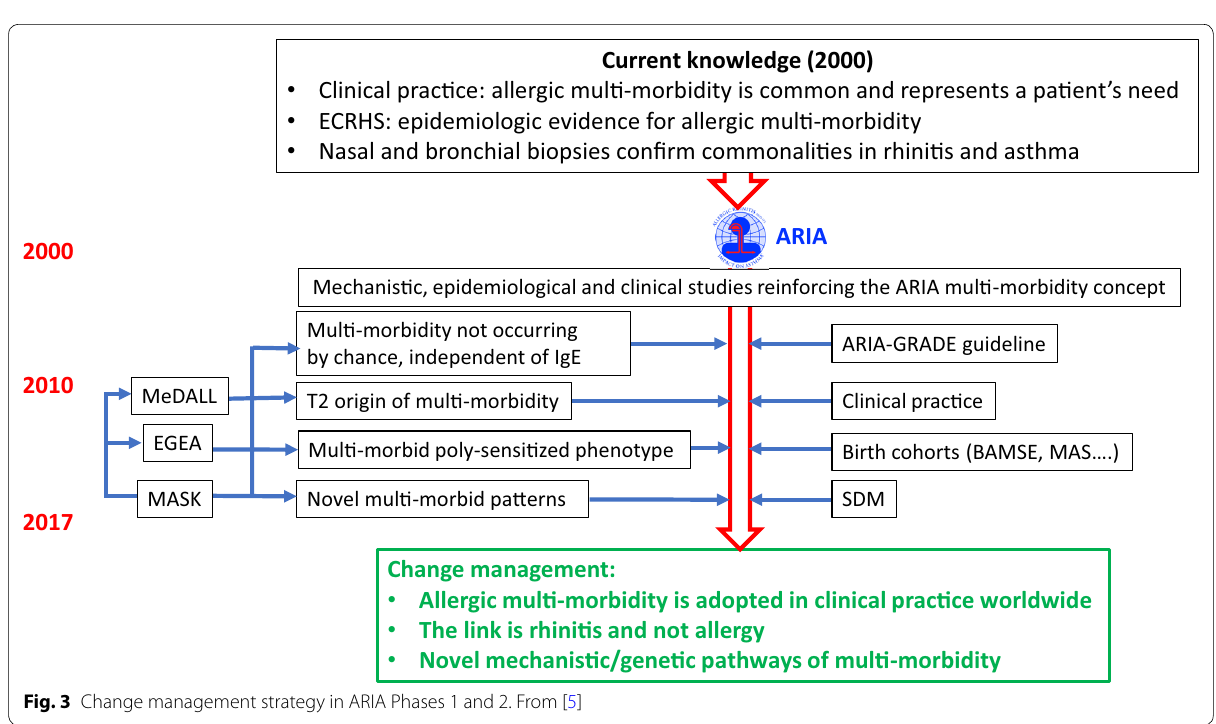
Fig. 3 Change management strategy in ARIA Phases 1 and 2. From [5]